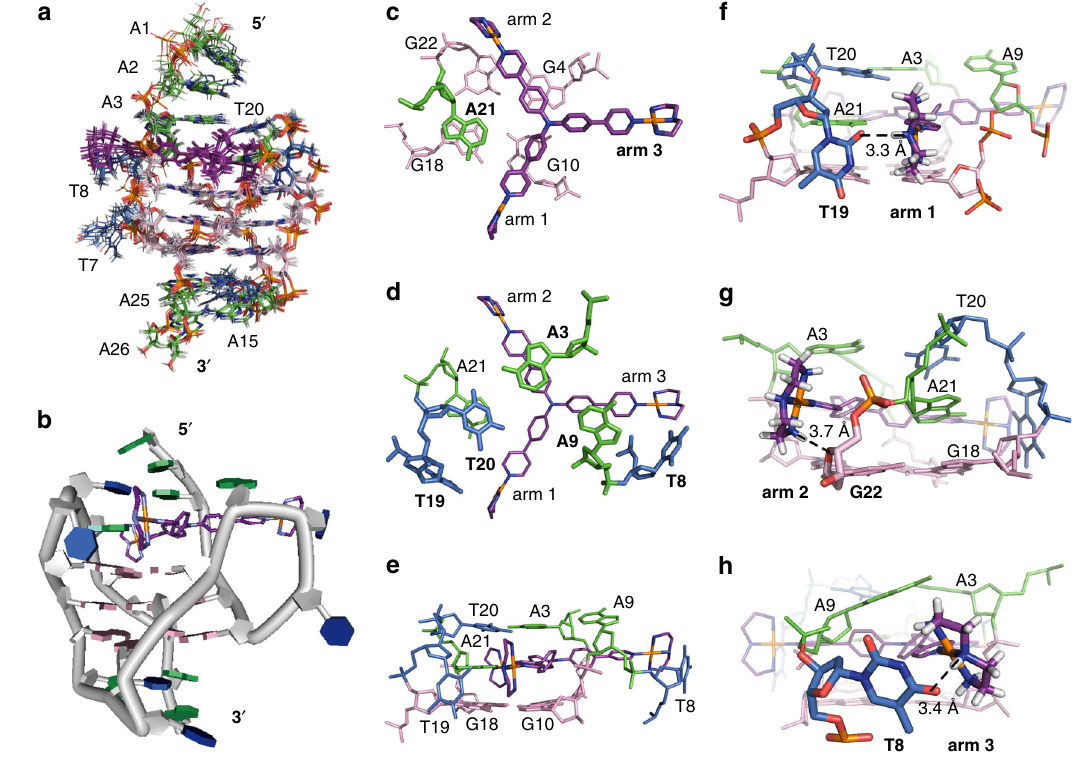
Fig. 4 Solution structure of the 1:1 Pt-tripod – Tel26 complex (PDB code: 5Z80). a The ensemble of the superimposed 15 NMR restraint-re fi ned structures of the 1:1 complex. b A representative structure of the 1:1 complex. c – e Three different views of the Pt-tripod-induced binding pockets at the 5 ʹ -end with residues labeled. f – h Potential hydrogen bonding and electrostatic interactions of three platinum units of Pt-tripod and Tel26 at the 5 ʹ -end, respectively. The distance between the NH of the fi rst platinum unit and the O2 of the T19 base (N-O) is 3.3 Å ( f ). The distance between the NH 2 of the second platinum unit and the oxygen of the G22 ribodesose (N-O) is 3.7 Å ( g ). The distance between the NH of the third platinum unit and the O4 of the T8 base (N-O) is 3.4 Å ( h ). Pt-tripod molecules are colored in purple. Guanines are colored in pink. Adenines are colored in green. Thymines are colored in